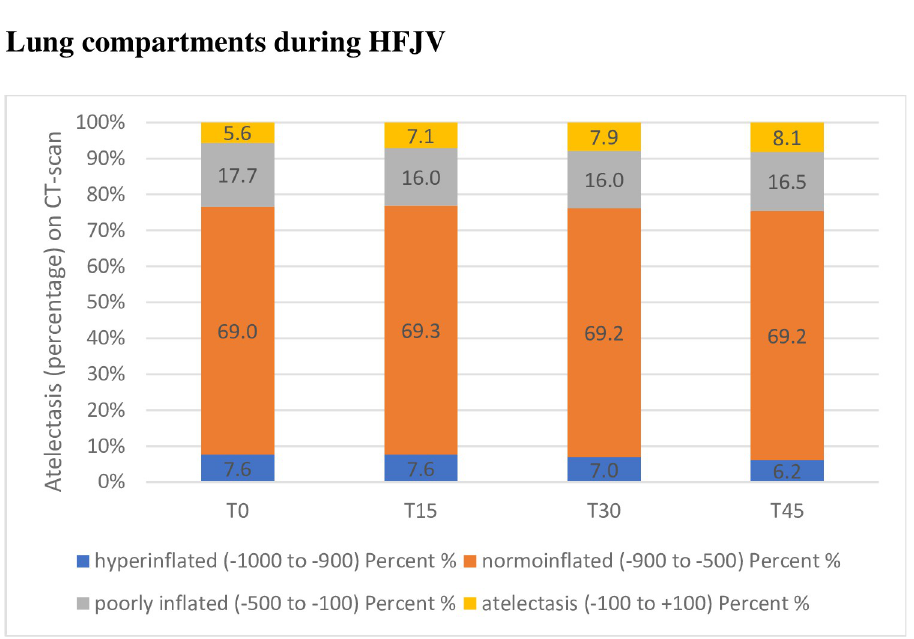
Fig 2. The four lung compartments, described as the mean percentage of the lung, during the time period studied. T = 0 being the first CT-scan after initiation of HFJV (high frequency jet ventilation) and thereafter CT-scans every 15 minutes. The normoinflated lung is unchanged during the whole time period studied (P = 0.8).